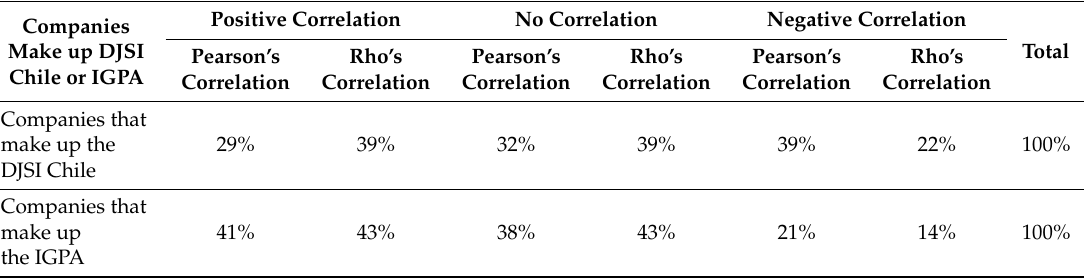
Table 2. Summary of ROE correlations with the DJSI